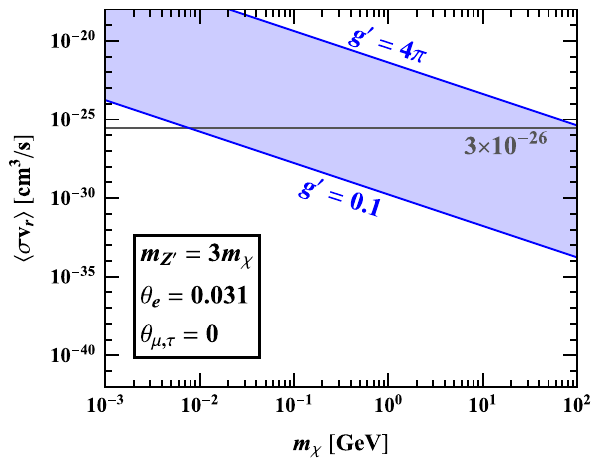
Fig. 7 Thermallyaveragedannihilationcrosssectionmultipliedbythe relative velocity for χχ → νν . We have fixed m Z (cid:9) = 3 m χ , θ e = 0 . 031, θ μ = θ τ = 0, and varied g (cid:9) between 0 . 1 and 4